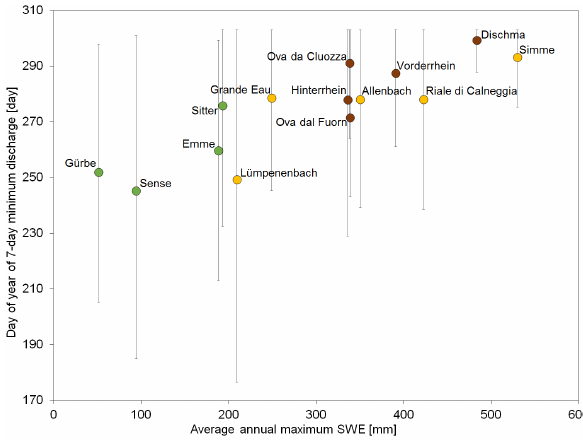
Figure 7. Day of year (DOY) with 7-day minimum discharge against long-term mean annual maximum SWE. Colour circles rep- resent catchment mean and whiskers represent 10 and 90% quan- tiles. The DOY “1” represents the first day of calendar year (1.1) and the DOY “365” represents 31.12. The colour of the circle indicates the catchment group according to mean elevation (dark brown: > 2000ma.s.l.; light brown: 1300–2000ma.s.l.; green: <